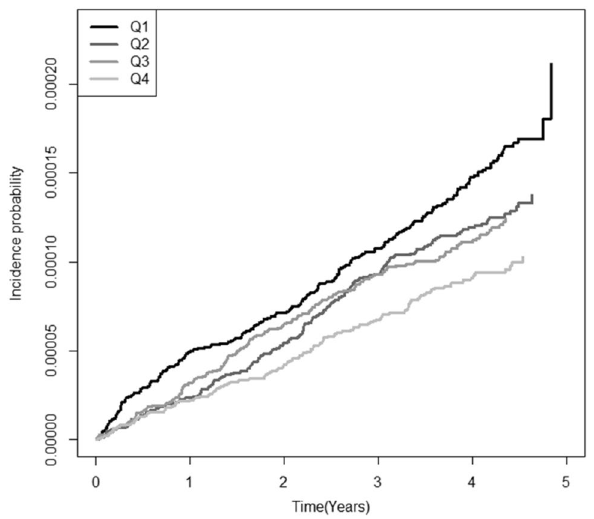
Figure 1. Kaplan–Meier curves showing the incidence of Behçet’s disease according to the quartiles (Q1–4) of high-density lipoprotein cholesterol levels.